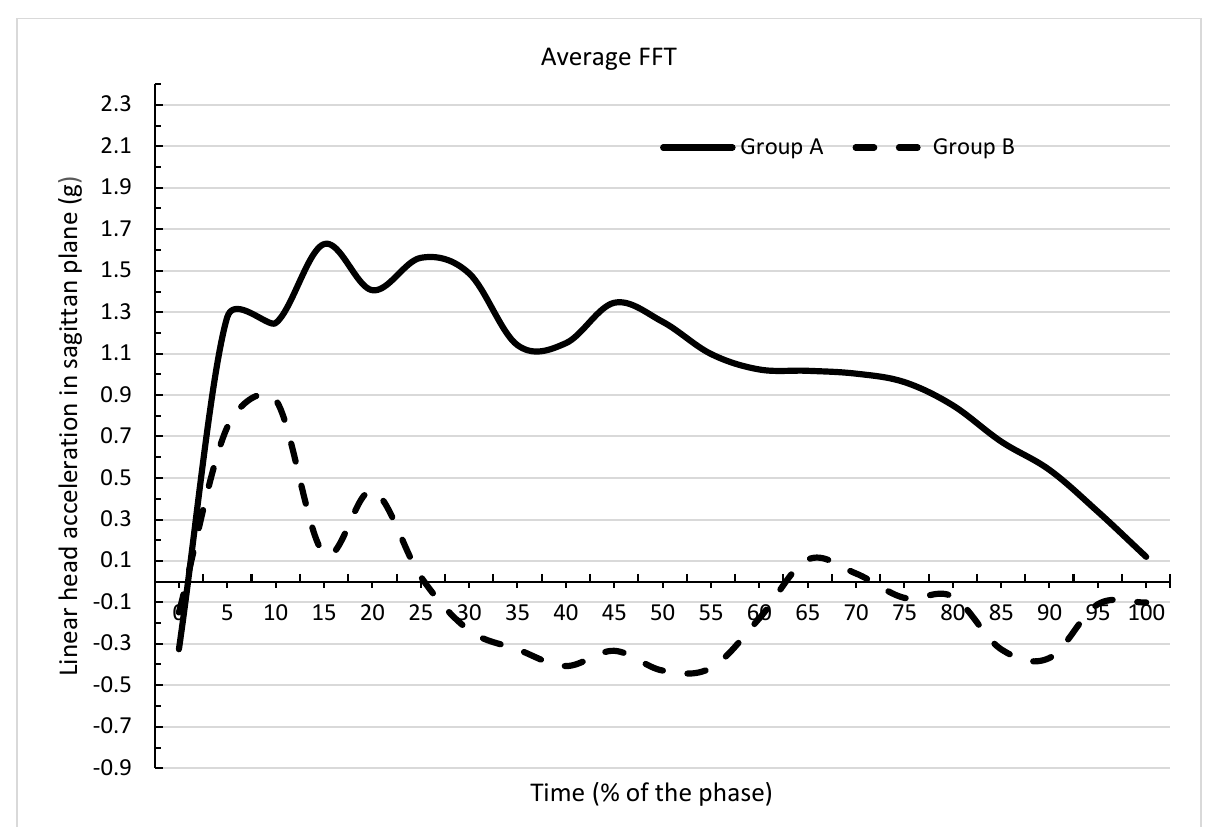
Figure 8. Dependence of mean values of linear head acceleration in the sagittal plane at the time of performing a backward fall in the form of FFT between groups A and B. Table 3. Comparison of the sagittal linear acceleration of the head with Student’s t -tests for inde- pendent variables for IFT between groups A and B.